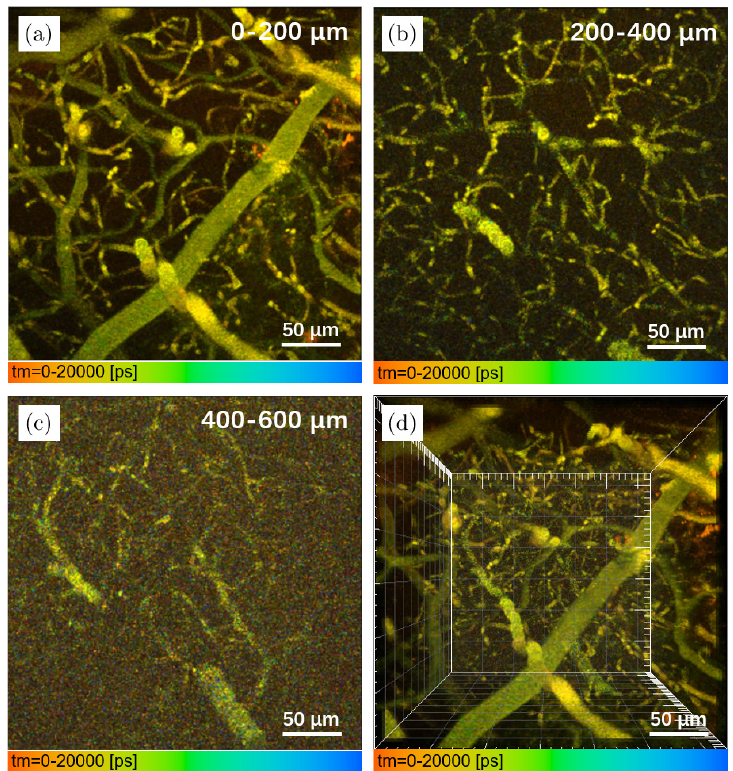
Fig. 3. In vivo 3PFLIM stacked images (every 200 (cid:1) m) of mouse with craniotomy brain vasculature at various vertical depths: (a) 0 (cid:4) 200 (cid:1) m, (b) 200 (cid:4) 400 (cid:1) m and (c) 400 (cid:4) 600 (cid:1) m. (d) 3D reconstruction of the blood vessels in brain with 600 (cid:1) m depth. (Scale bar: 50 (cid:1)